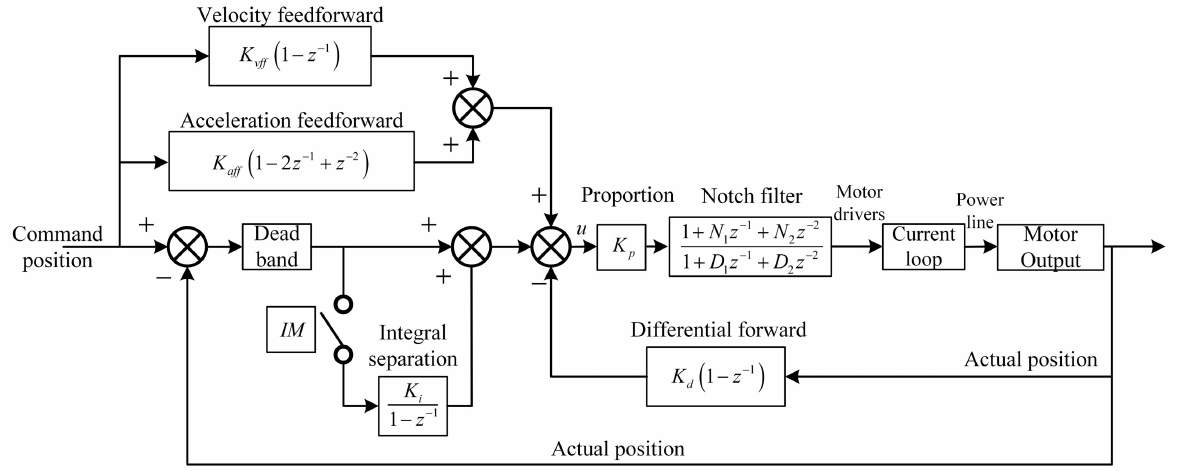
Figure 11. Diagram of the servo control